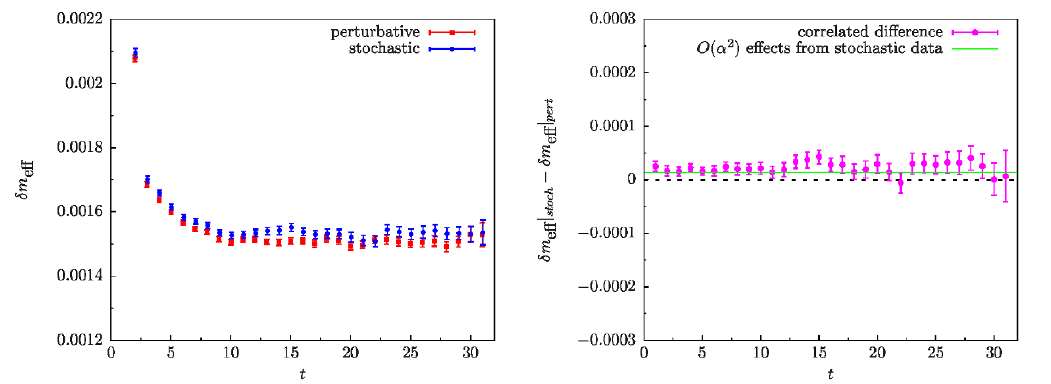
Figure 6 . The QED correction to the e(cid:11)ective mass of a charged kaon. The plot on the left shows a comparison between stochastic (blue circles) and perturbative (red squares) data, the plot on the right shows the correlated di(cid:11)erence of both datasets. The solid green line shows the O ( (cid:11) 2 ) e(cid:11)ects which are included in the stochastic data, i.e. the expected discrepancy between stochastic and perturbative